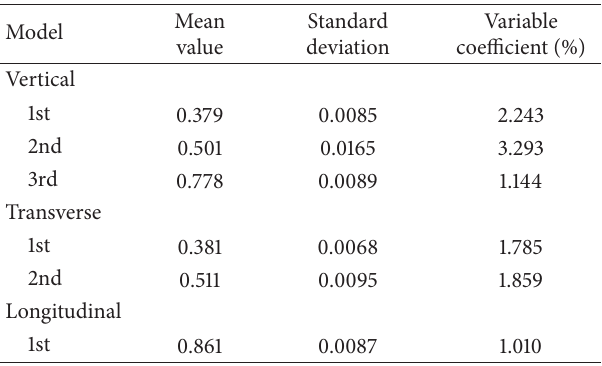
Table 11: The statistics of measured frequencies.